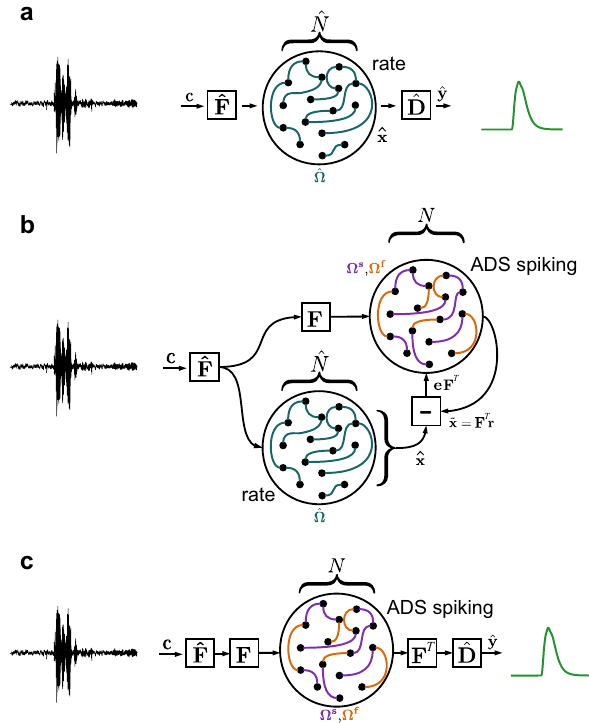
Figure 1. Schematic overview of our supervised training approach. ( a ) A recurrent non-spiking neural network with ˆ N neurons (“rate”) is trained using BPTT or a similar approach to implement the mapping c → ˆ y , via encoding and decoding weights ˆ F and ˆ D , using the recurrent weights ˆ (cid:31) and resulting in the internal temporal representation of neural activity ˆ x . ( b ) To train a robust spiking network for the task, a network with N = ˆ N LIF neurons (“ADS spiking”) is initialised with fast balanced feedback connections (cid:31) a randomly chosen encoding matrix F . The ADS spiking network learns to represent the target signals ˆ x with reference to an error signal e = ˜ x − ˆ x , by adapting slow feedback connections (cid:31) spiking network replaces the non-spiking rate network, and uses the encoding and decoding weights ˆ F and ˆ D to implement the trained task mapping c → ˆ y